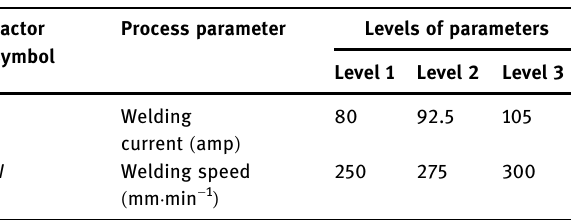
Table 2: Levels of welding process